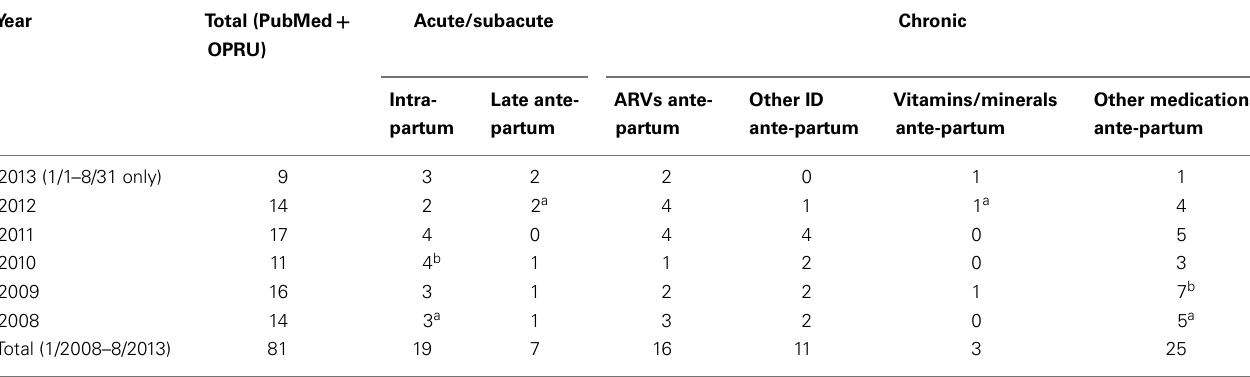
Table 1 | Classification of search results for recent clinical trials of pharmacokinetics and pregnancy.